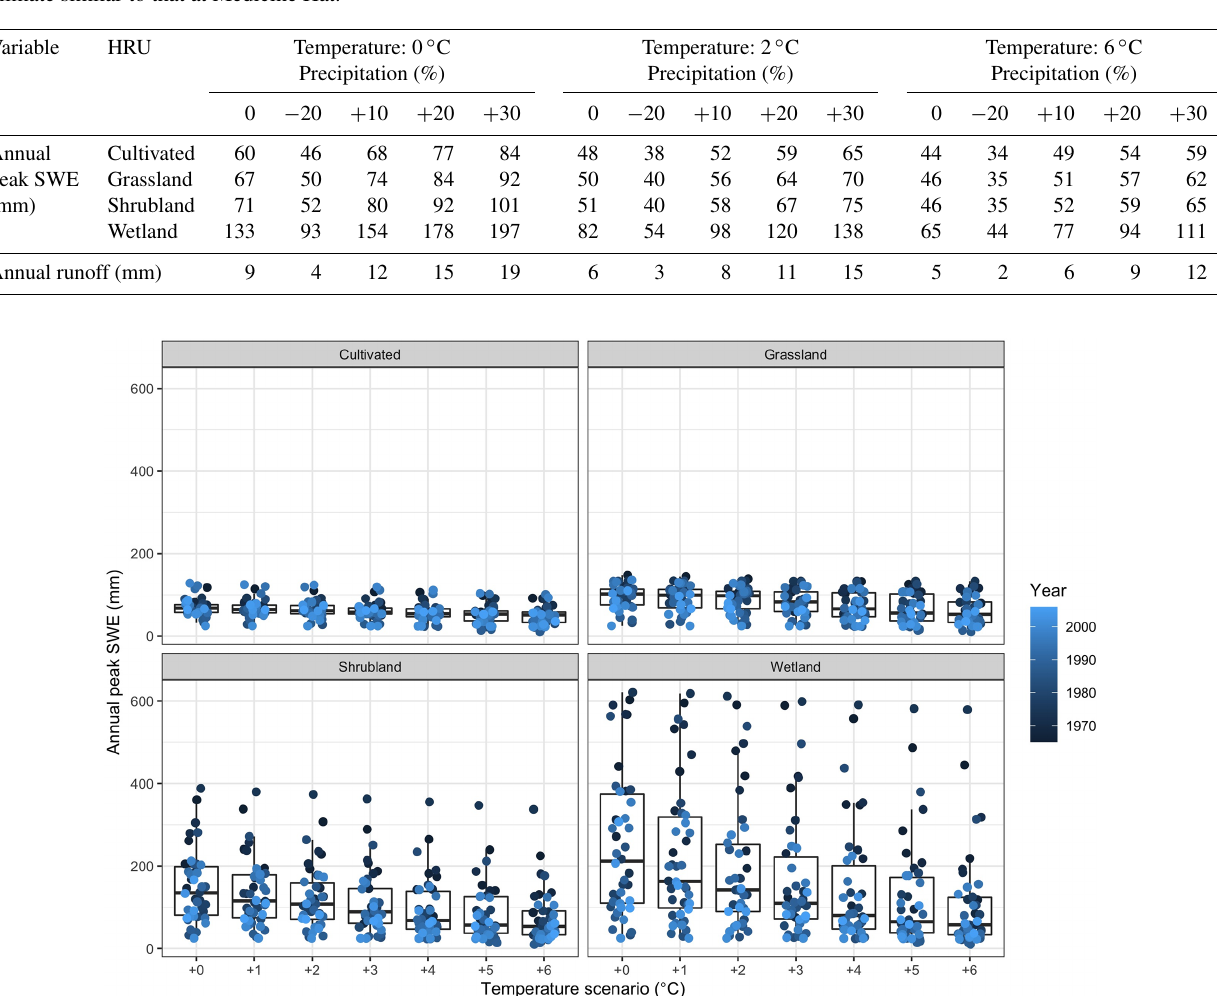
Table 4. Simulated annual peak snow water equivalent (SWE) for different hydrologic response units (HRUs) and basin runoff under different climate scenarios (temperature and precipitation expressed as degrees C or percentage change from the reference scenario, respectively), with a climate similar to that at Medicine Hat.